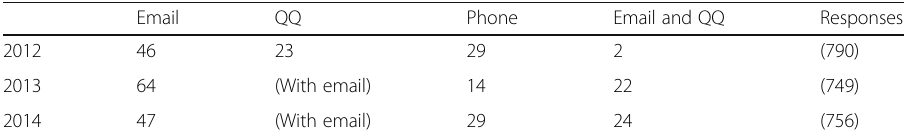
Table 1 Tracking methods and responses (in